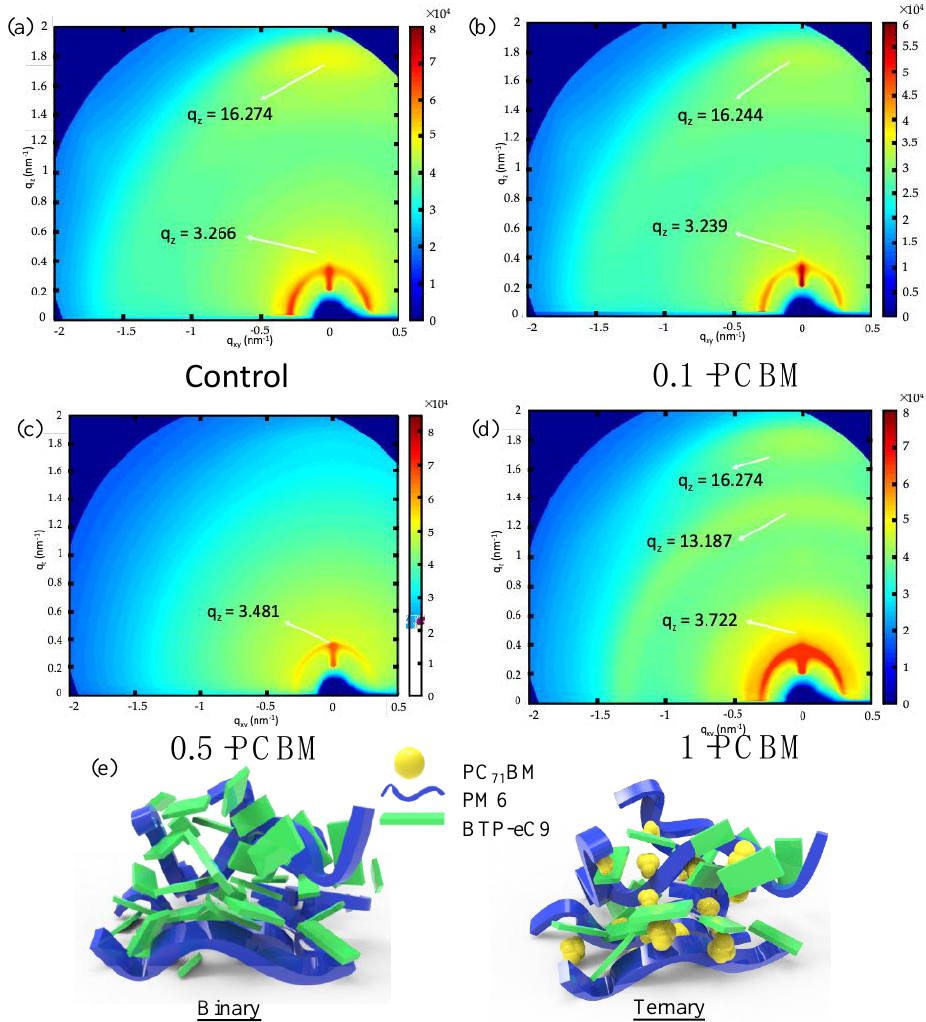
Figure 4. ( a – d ) GIWAXS images of the ( a ) binary, ( b ) 0.1–PCBM, ( c ) 0.5–PCBM, and ( d ) 1–PCBM blends. ( e ) Cartoon illustration of blend morphology.